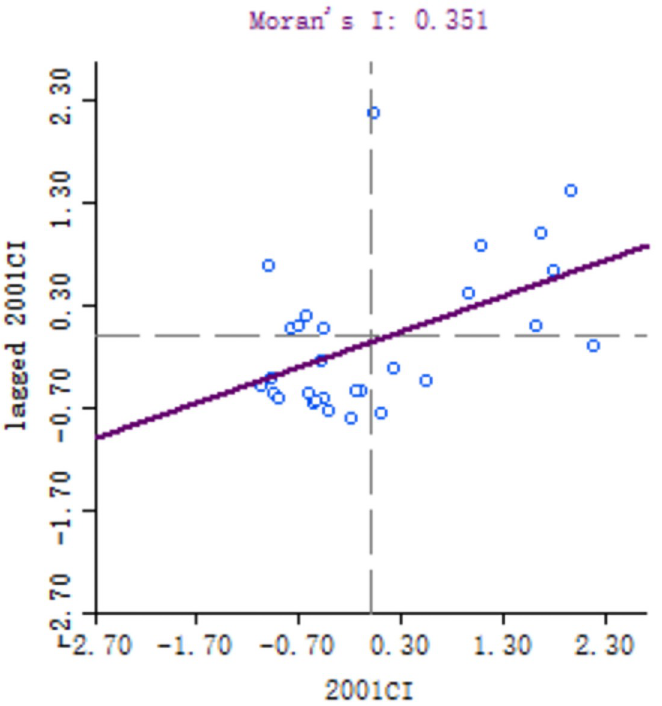
Fig 4. Moran scatter chart of industrial high quality development level in 2001.